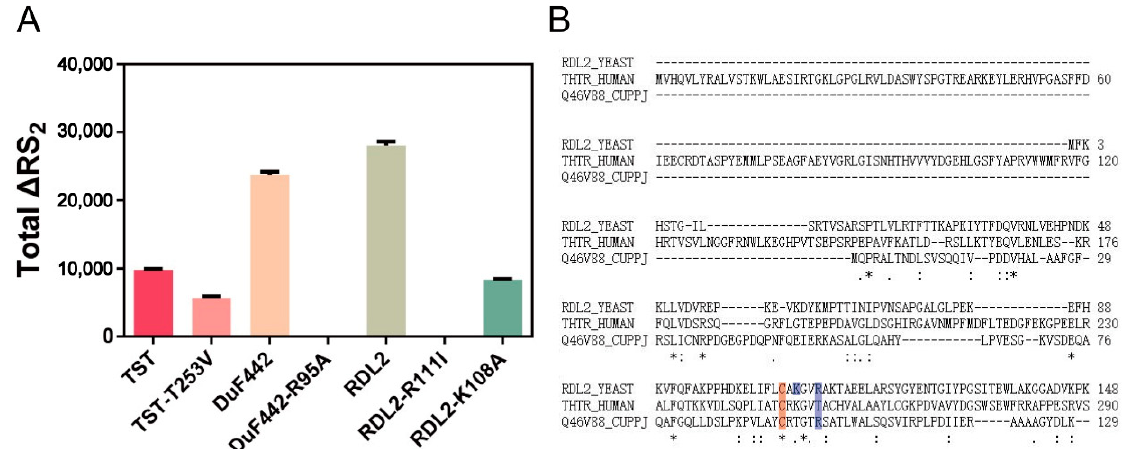
Figure 3. Total Δ RS 2 values of enzymes and their mutants. ( A ) After reacting with thiosulfate, TST, DUF442, and RDL2 show positive total Δ RS 2 values, indicating they form Cys-SSH intermediates; TST-T253V and RDL2-K108A mutants show decreased total Δ RS 2 values compared to wt, indicating they contain less Cys-SSH than corresponding wt; DUF442-R95A and RDL2-R111I show zero Δ RS 2 values, indicating they contain no Cys-SSH. ( B ) Sequence alignment of the rhodaneses. The conserved cysteine residue and mutation sites are shaded in color. * indicates the conserved residue.